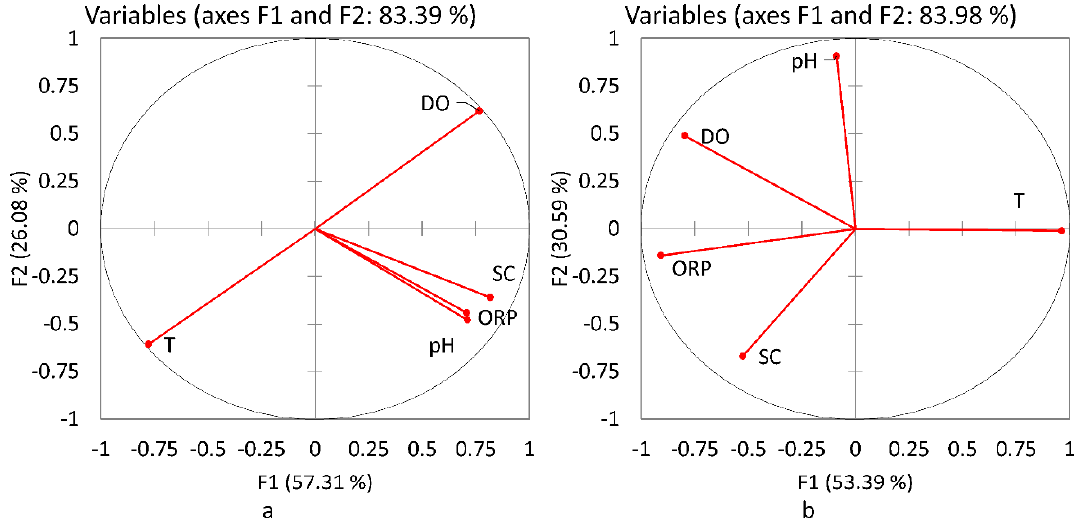
Figure 5. Scatter plots of the daily values of some parameters (( a ) ORP, ( b ) pH, ( c ) SC) at Ti¸s ă u¸ti (downstream) and the di ff erence between the daily average values of the same parameters at Ti¸s ă u¸ti and Mihoveni (linear trendline and coe ffi cient of determination included).